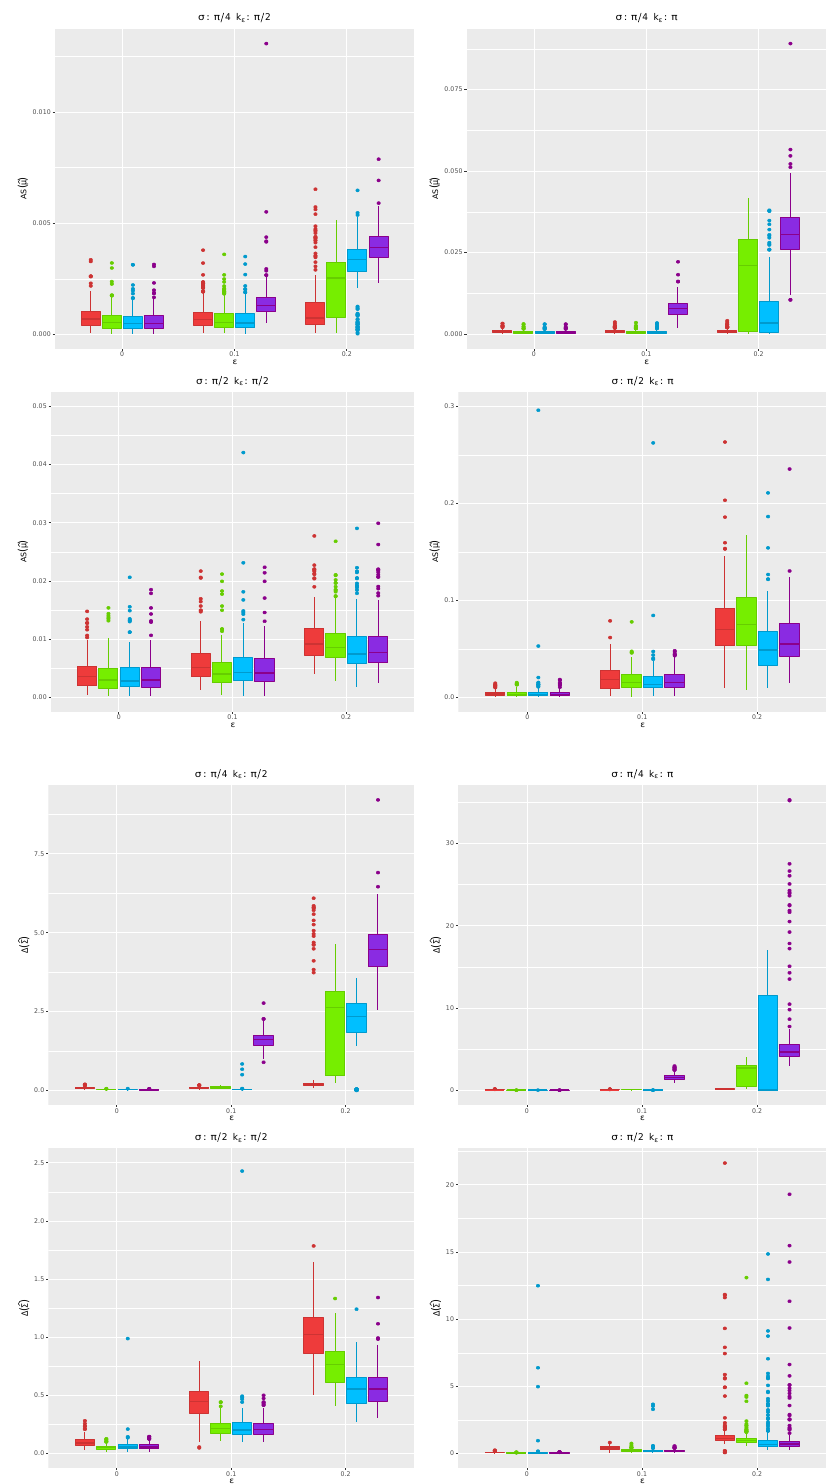
Figure 6. Boxplots of the angular separation ( top ) and divergence ( bottom ) values obtained using (from left to right) MCD (red), MM (green), WLE (blue), and MLE (violet) with respect to the contamination level (cid:101) , with p = 5 and n =